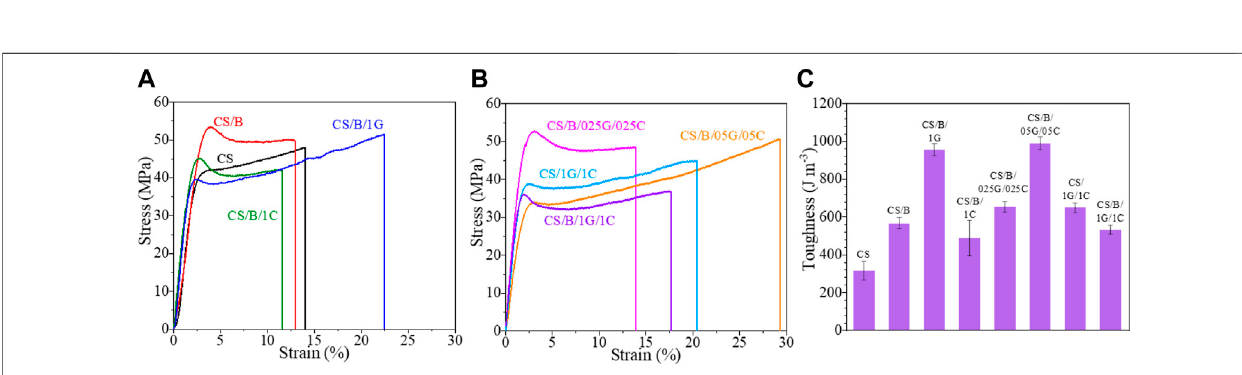
Frontiers in Chemistry |